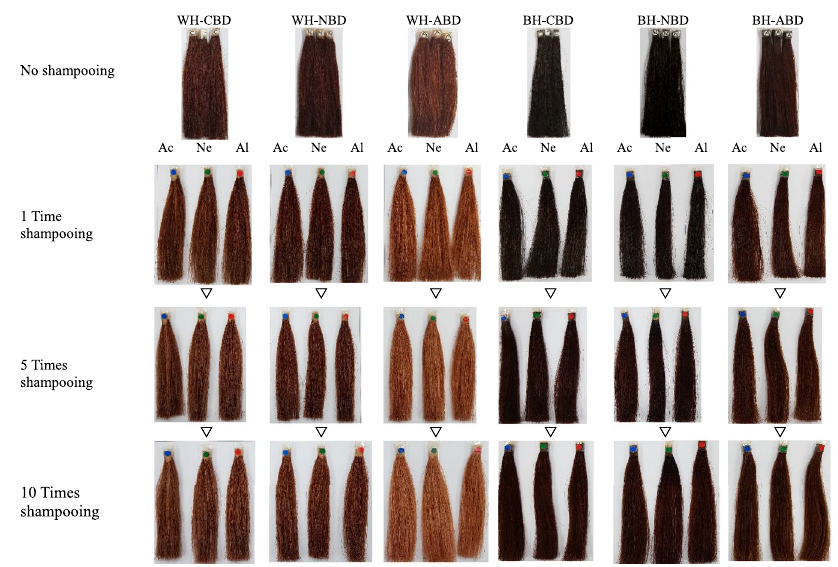
Fig. 3 White hair (WH) and bleached hair (BH) dyed with Cationic (CBD), Nonionic (NBD), and Anionic (ABD) basic hair dye before and after up to 10 times of shampooing. Ac acidic shampoo, Ne neutral shampoo, Al alkaline shampoo